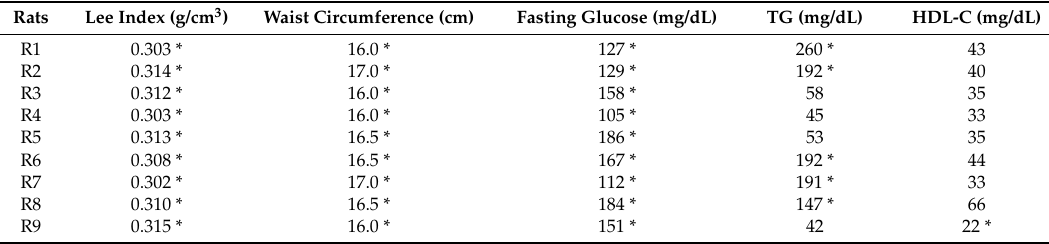
Table 3. Study Wistar rats according to measures and biochemical parameters used for metabolic syndrome diagnosis. Rats Lee Index (g/cm 3 ) Waist Circumference (cm) Fasting Glucose (mg/dL) TG (mg/dL) HDL-C (mg/dL)